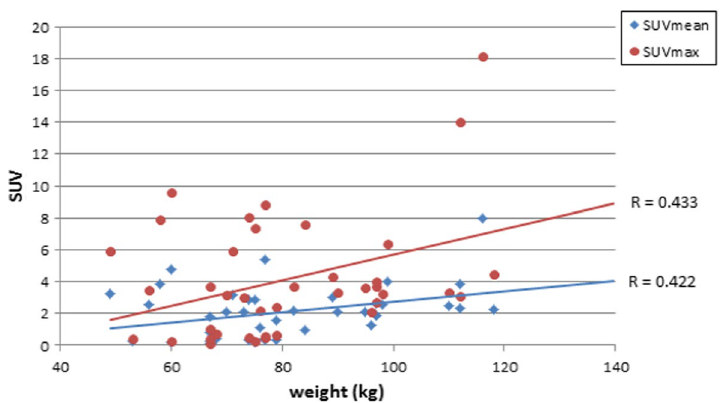
Fig. 5 Pearson correlation coefficient between Lesion SUV versus patient’s weight in kg with respect to